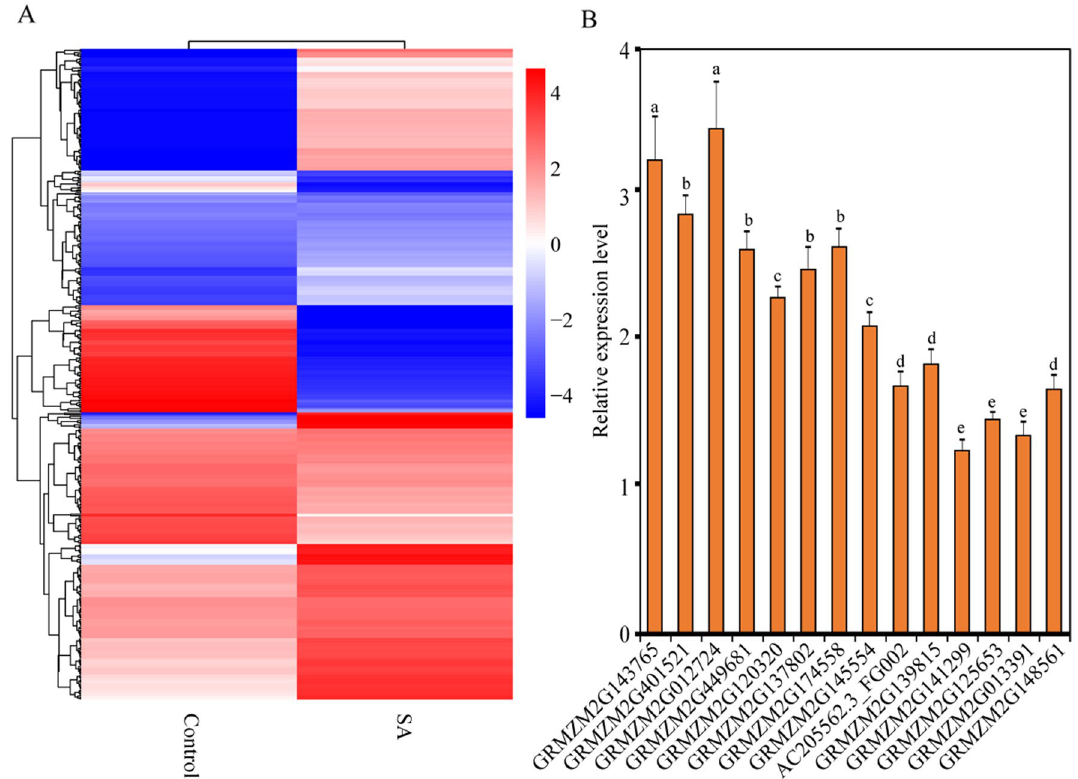
Figure 1. De novo transcriptomic sequence analyses of maize under SA stresses. ( A ) The cluster analyses of differential expression genes under SA treatments. ( B ) the transcription levels of the 14 WRKY transcription factors under SA treatments. Vertical bars indicate ± SE of three